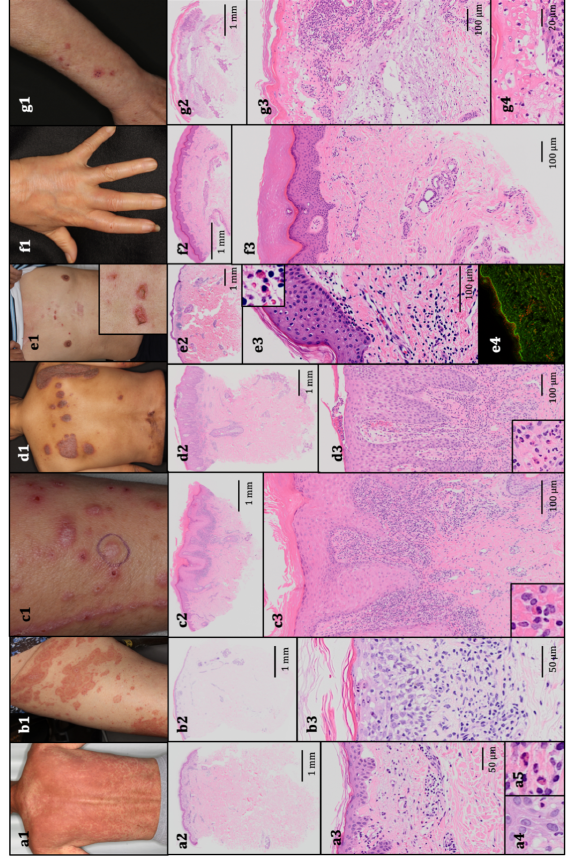
Figure 1. The representative clinical presentations and histopathological features. ( a1 ) Maculopapu- lar rash, grade 3. The patient received pembrolizumab for stage IV non-squamous non-small-cell lung cancer. Histopathology revealed vacuolar degeneration at the dermal–epidermal junction, perivascu- lar infiltration of lymphocytes and eosinophils, and necrotic keratinocytes (hematoxylin and eosin (HE); ( a2 ) 10 × , ( a3 ) 200 × , and ( a4 , a5 ) 400 × original magnification). ( b1 ). Erythema multiforme, grade 2. The patient received nivolumab for stage IV squamous non-small-cell lung cancer. Histopathology revealed vacuolar degeneration at the dermal–epidermal junction and perivascular infiltration of lymphocytes and eosinophils, histopathologically resembling maculopapular rash (HE; ( b2 ) 10 × and ( b3 ) 200 × original magnification). ( c1 ). Lichenoid reaction, grade 1. The patient received nivolumab for metastatic melanoma. Histopathology revealed the lichenoid infiltration of lymphocytes and a few eosinophils, and the epidermis exhibited acanthosis, a thickened granular layer, orthokeratotic hyperkeratosis, and spongiosis (HE; ( c2 ) 10 × and ( c3 ) 100 × original magnification). ( d1 ) Psoriasiform reaction, grade 2. The patient received atezolizumab for stage IV non-squamous non-small-cell lung cancer. Histopathology revealed epidermal hyperkeratotic parakeratosis and acanthosis without a granular layer, elongation of rete ridges and dermal papilla, mild vacuolar degeneration at the dermal–epidermal junction, and perivascular infiltration of lymphocytes, eosinophils, and neu- trophils in the upper dermis (HE; ( d2 ) 10 × and ( d3 ) 100 × original magnification). ( e1 ). Bullous pemphigoid, grade 1. The patient received pembrolizumab for metastatic melanoma. Histopathology revealed subepidermal bulla with eosinophils and perivascular infiltration of lymphocytes and eosinophils (HE; ( e2 ) 10 × and ( e3 ) 100 × original magnification). ( e4 ) A direct immunofluorescence test revealed the linear deposition of IgG. ( f1 ). Scleroderma-like reaction, grade 1. The patient received nivolumab for stage IV gastric adenocarcinoma. Histopathology revealed an increased amount of thick collagen fibers that packed sweat glands (HE; ( f2 ) 10 × and ( f3 ) 100 × original mag- nification). ( g1 ). Stevens–Johnson syndrome, grade 3. The patient received nivolumab for stage IV non-squamous non-small-cell lung cancer. Histopathology revealed epidermal necrosis with numerous necrotic keratinocytes, acantholytic bullae, infiltration of lymphocytes and eosinophils, and parakeratotic hyperkeratosis (HE; ( g2 ) 10 × , ( g3 ) 100 × , and ( g4 ) 400 × original